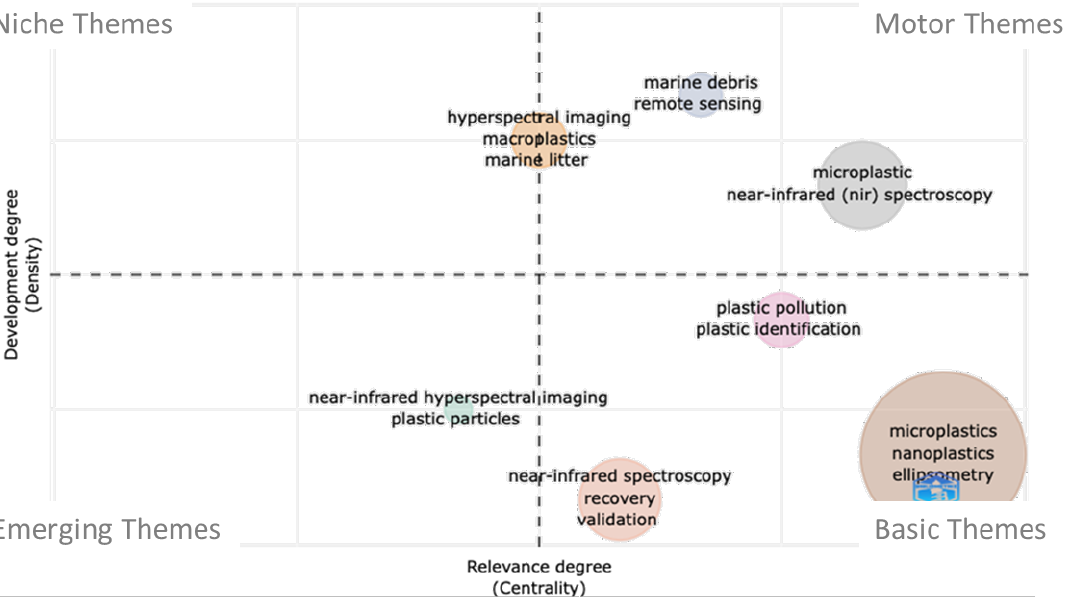
Figure 11. Thematic Map limited to NIR-related literature. The main theme is in Q1, followed by highly developed and specialized themes that connect to the main theme in Q2, fading or emerging themes in Q3, and foundational and transversal themes in Q4. The map was generated using the open-source tool Biblioshiny for Bibliometrix [38].